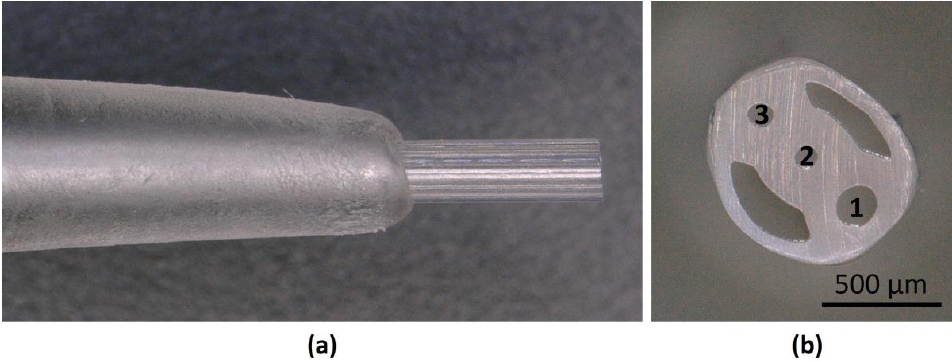
Figure 1. Vivostat ® system with the application kit spray pen VS 305: ( a ) Side view; ( b ) Front view (cross-section of the spray pen) with 1—air opening, 2 and 3—solution openings.